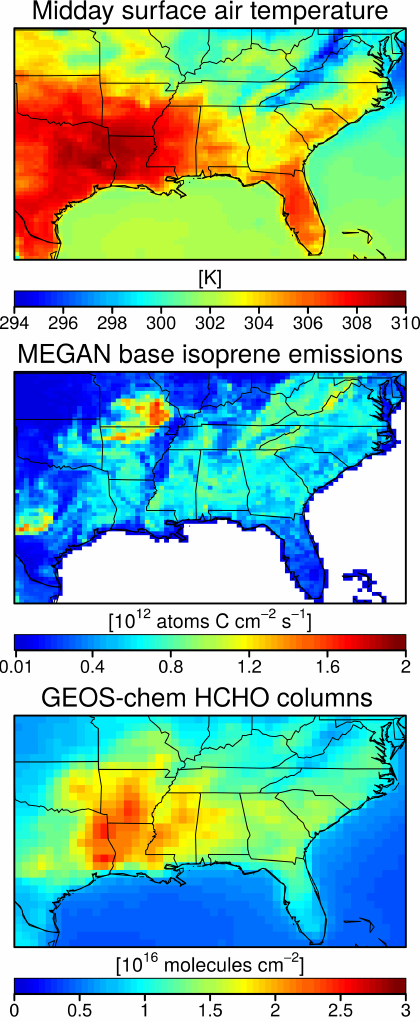
Figure 3. Mean temperature, base isoprene emissions and HCHO columns in the GEOS-Chem model for the SEAC 4 RS period (5 August–25 September 2013). The top panel shows the mid- day (12:00–13:00LT) surface air temperature from the GEOS- FP assimilated meteorological data. The middle panel shows the MEGAN 2.1 base isoprene emissions from Guenther et al. (2012) for standard conditions (air temperature = 303K; photosynthetic photon flux density = 200µmolm − 2 s − 1 for sunlit leaves and 50µmolm − 2 s − 1 for shaded leaves.) The bottom panel shows the GEOS-Chem HCHO columns computed with MEGAN 2.1 iso- prene emissions and sampled at 13:30LT, under OMI-SAO sched- ule, and filtered by OMI-SAO quality flags and cloud conditions.